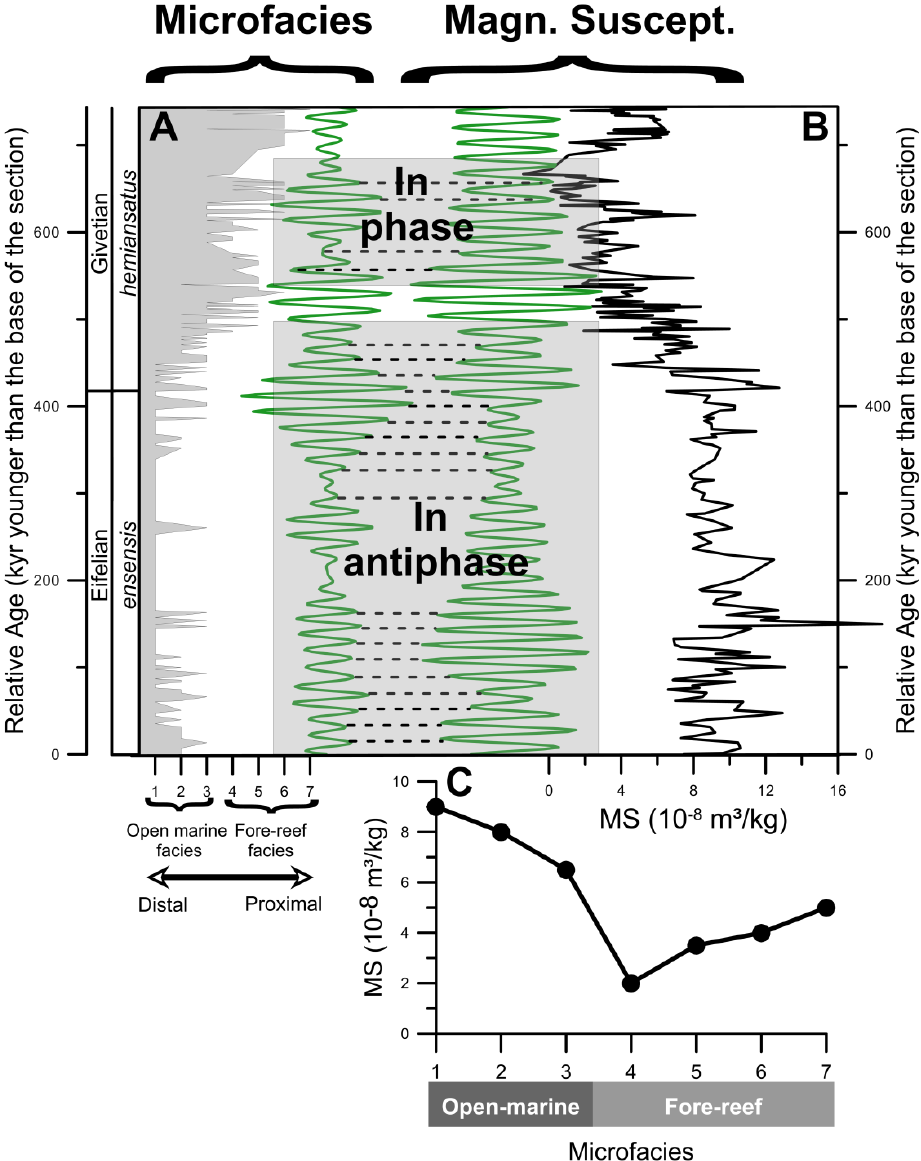
Fig. 9. Precessional microfacies variation vs. precessional Magnetic Susceptibility variation. (A) : microfacies curve plotted against a time-axis and band-pass filtered microfacies curve at the frequency of precession (between 15 and 23 kyr; left). (B) : Magnetic Susceptibility series plotted against a time-axis and band-pass filtered MS series at the frequency of precession (between 15 and 23 kyr; right). (C) : evolution of mean MS values on a relative proximity transect (after Da Silva et al., 2009). The reversal of the slope of the MS evolution on a relative proximity transect explains why precession-scale variations of microfacies and MS are in antiphase in the lower part of the section and in phase in the upper part of the section.